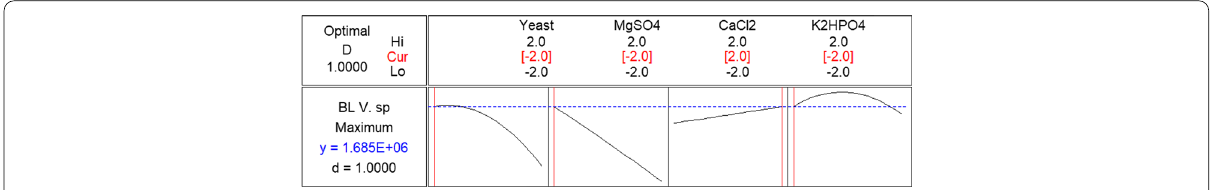
Fig. 7 Response optimizer and desirability function of V. sp. 6HFE bioluminescence